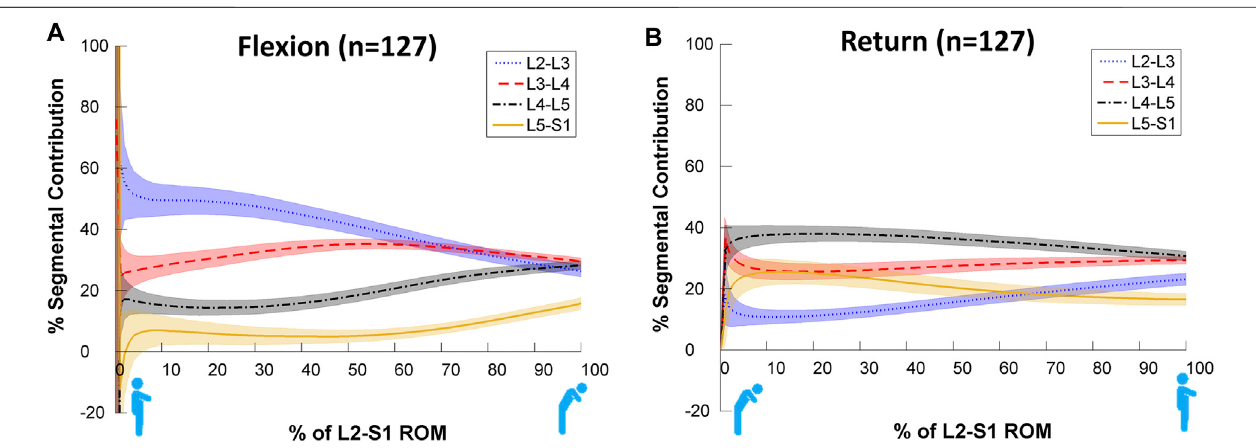
FIGURE 3 | Average segmental contribution to lumbar fl exion [ (A) : Flexion and (B) : return to standing] with 95% con fi dence intervals (shaded areas) in the Reference Database cohort.